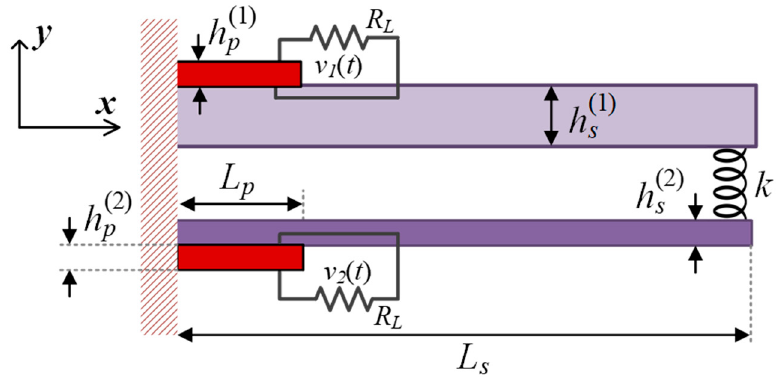
Figure 1. Schematic view of the system under study.